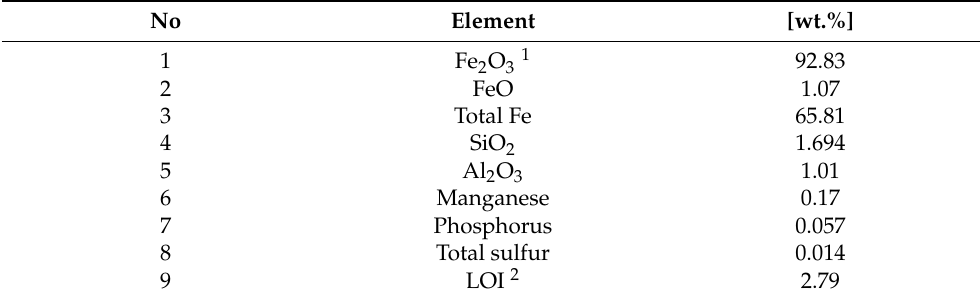
Table 3. Chemical composition of the Carajas iron ore.